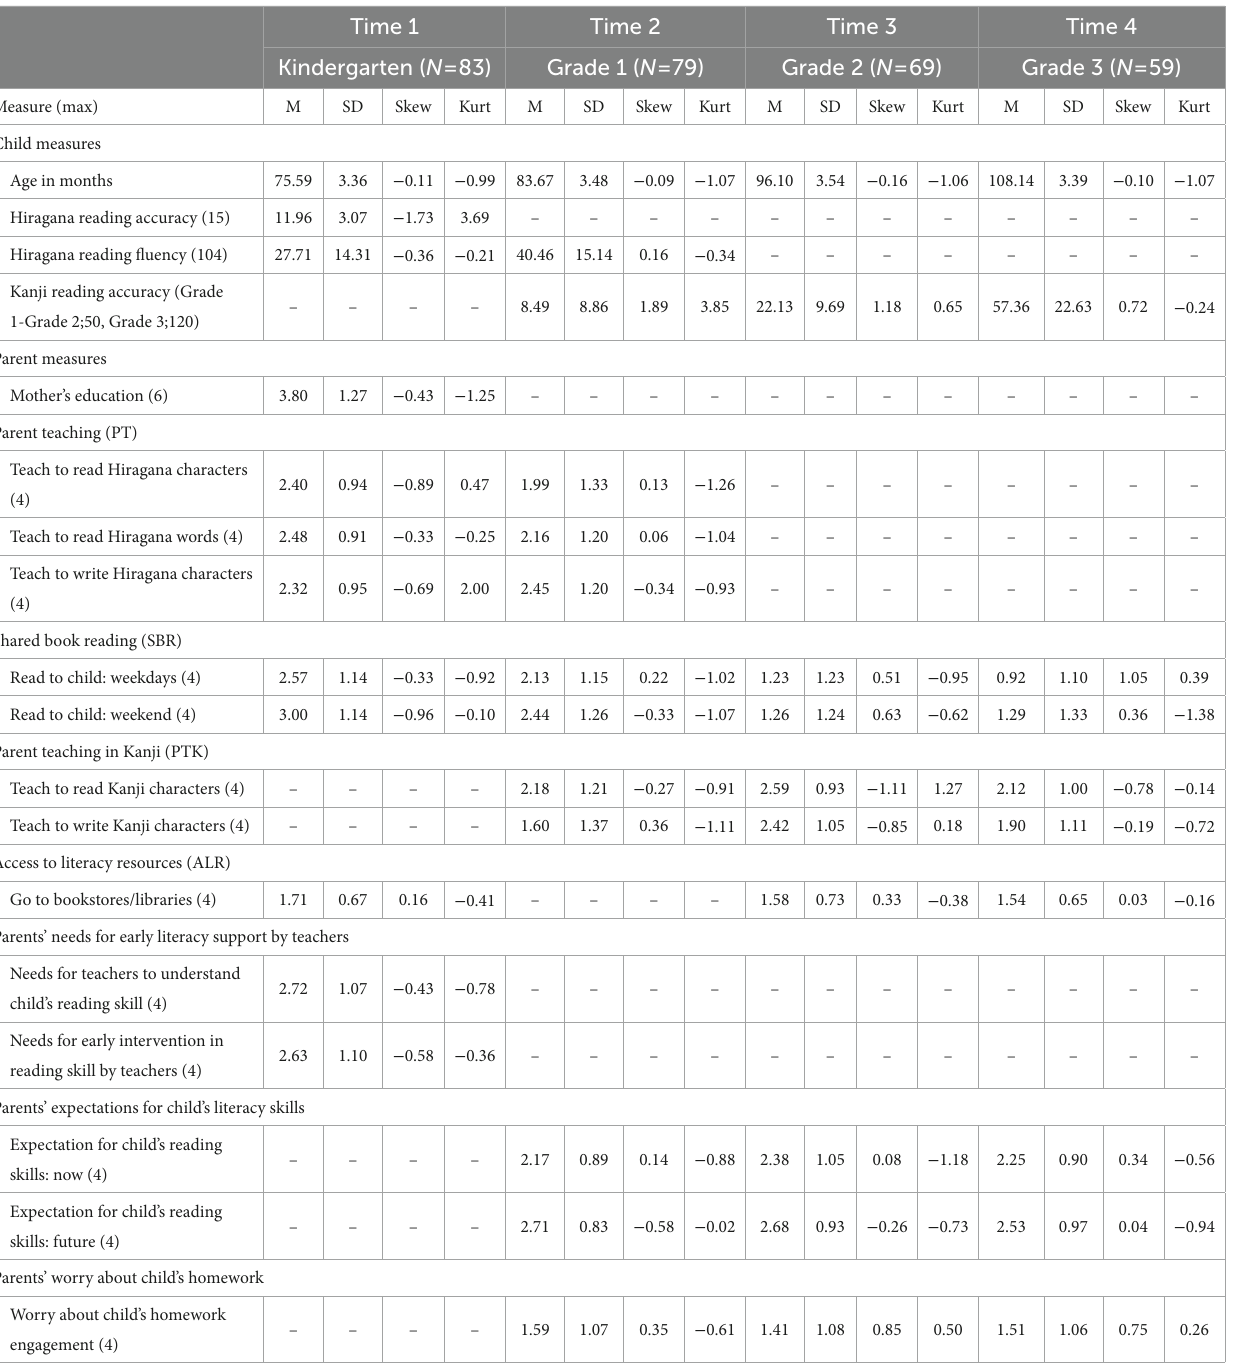
TABLE 1 Descriptive statistics for child and parent